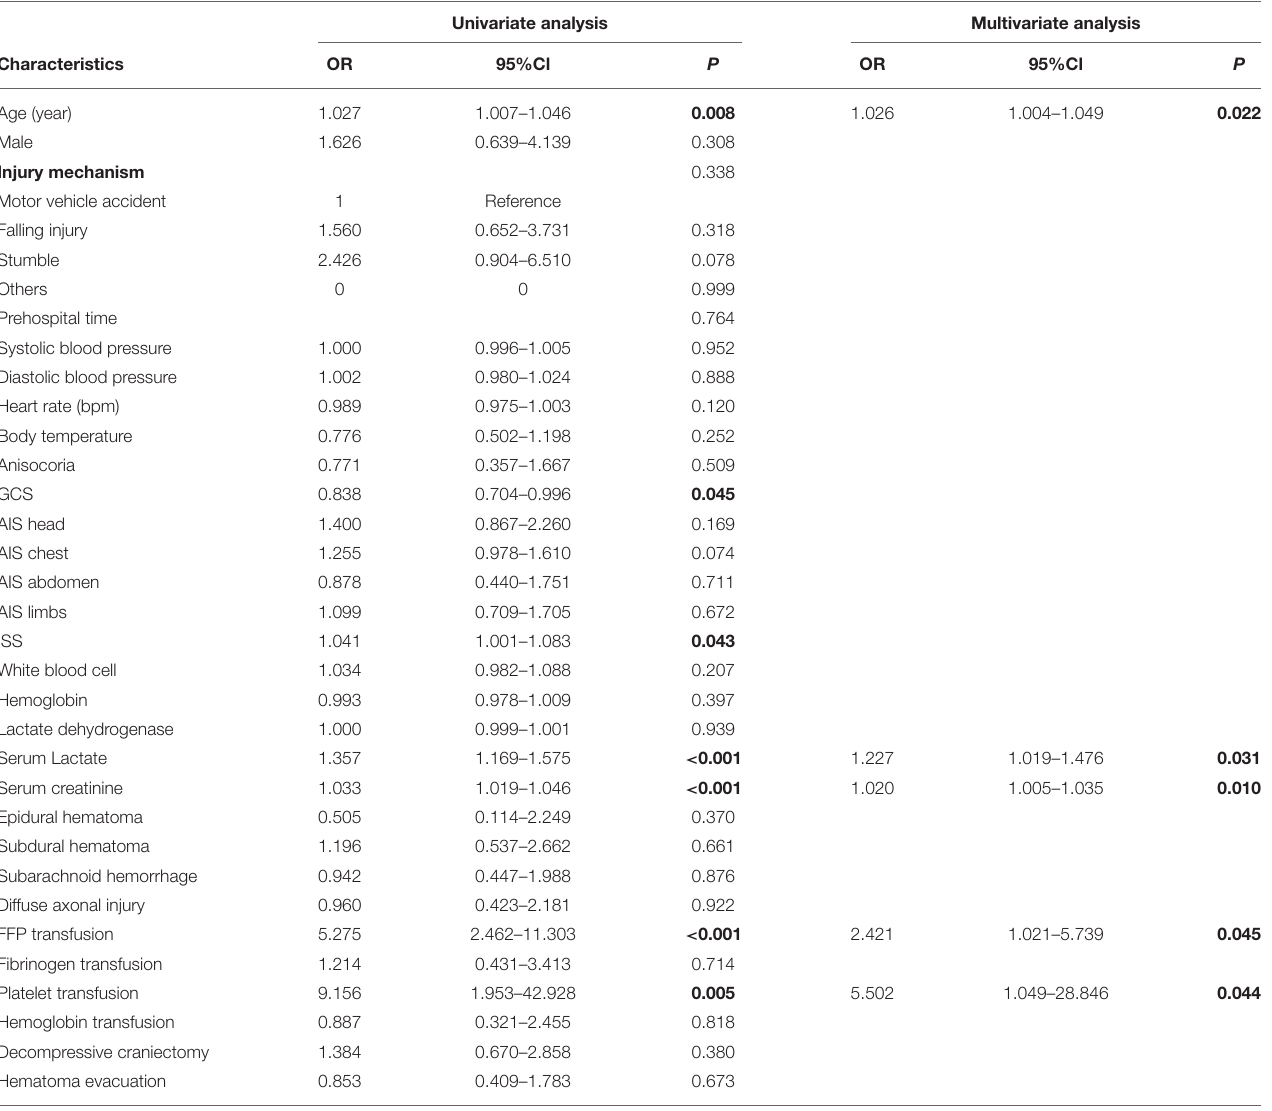
TABLE 2 | Univariate and multivariate logistic regression analyses for risk factors of AKI in included TBI patients. Univariate analysis Multivariate